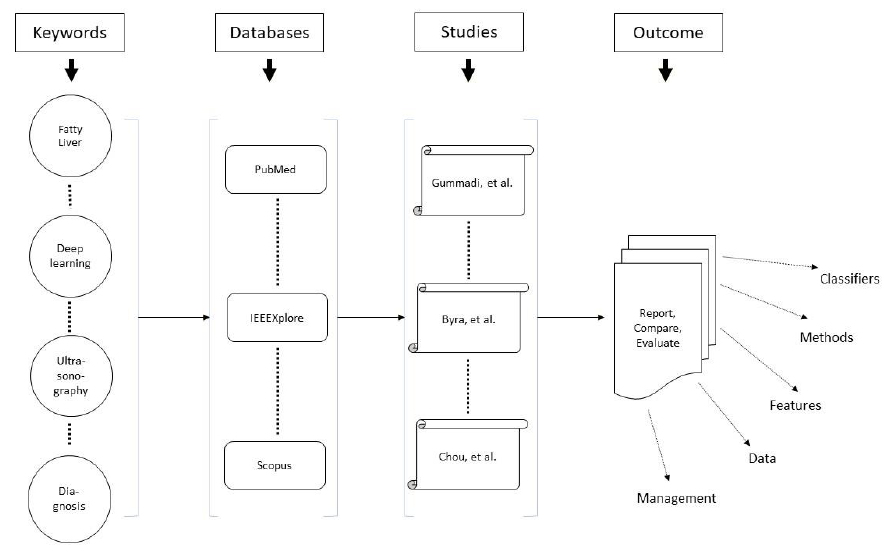
Figure 3 . Method Summary . Figure 3. Method